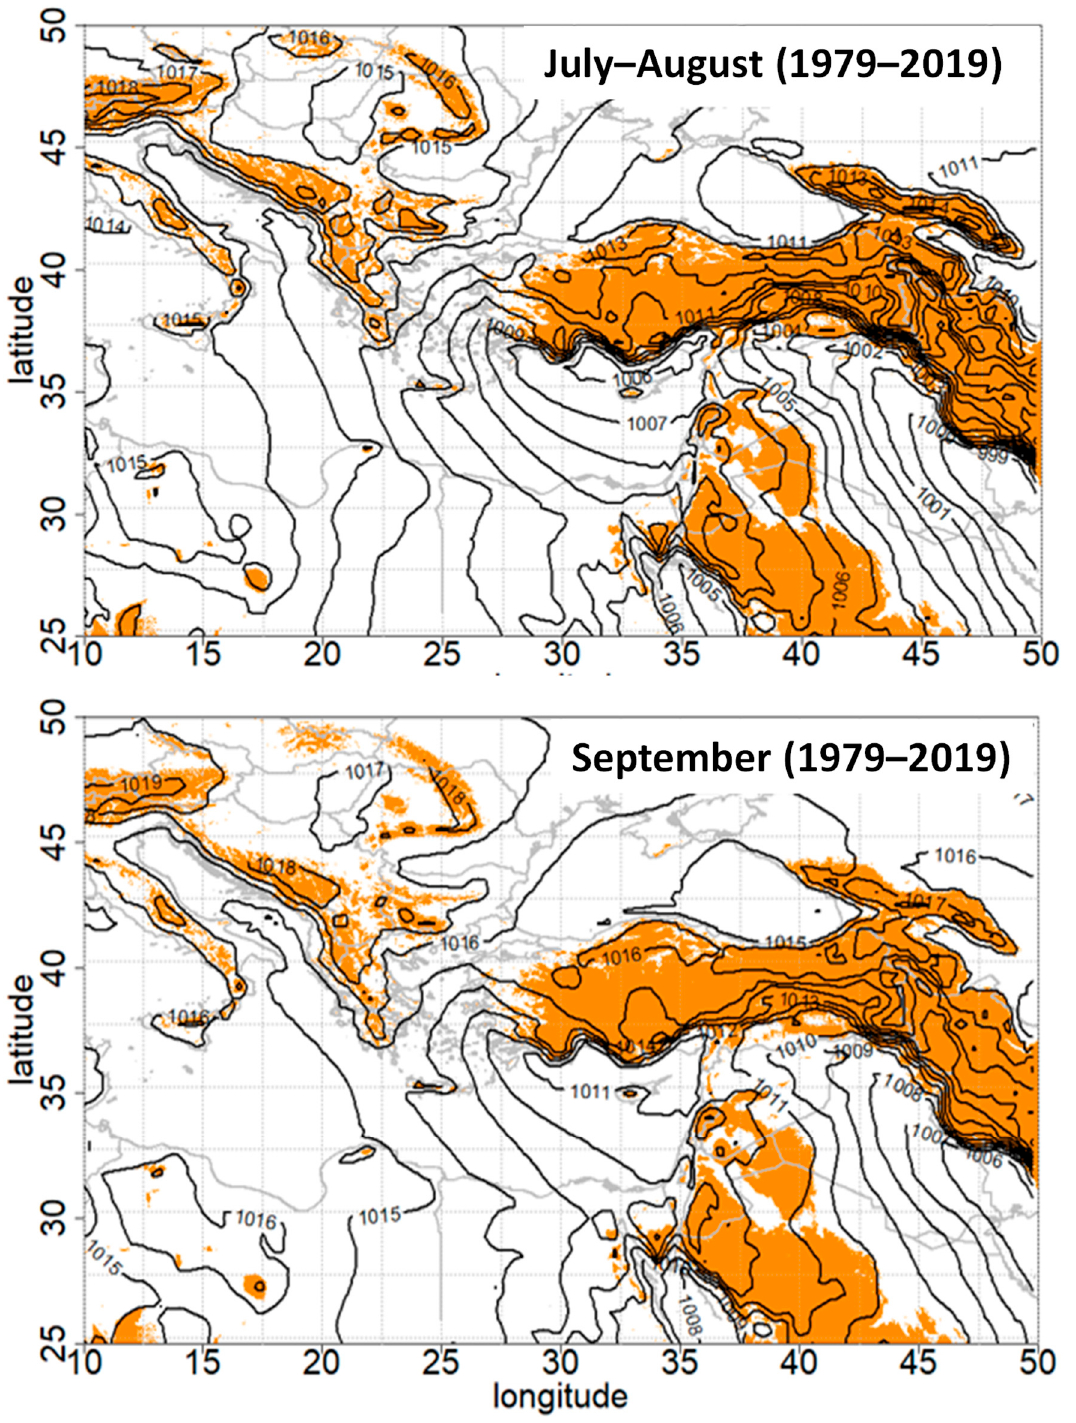
Figure 3. European Centre for Medium-Range Weather Forecasts (ECMWF) Reanalysis (ERA5) average mean sea level pressure (mb) at 06:00 UTC for the period of 1979–2019 during ( top ) July–August and ( bottom ) September. Elevation higher than 700 m is shown by shaded areas. An almost double pressure gradient is evident over the Aegean Sea for July and August compared to September.